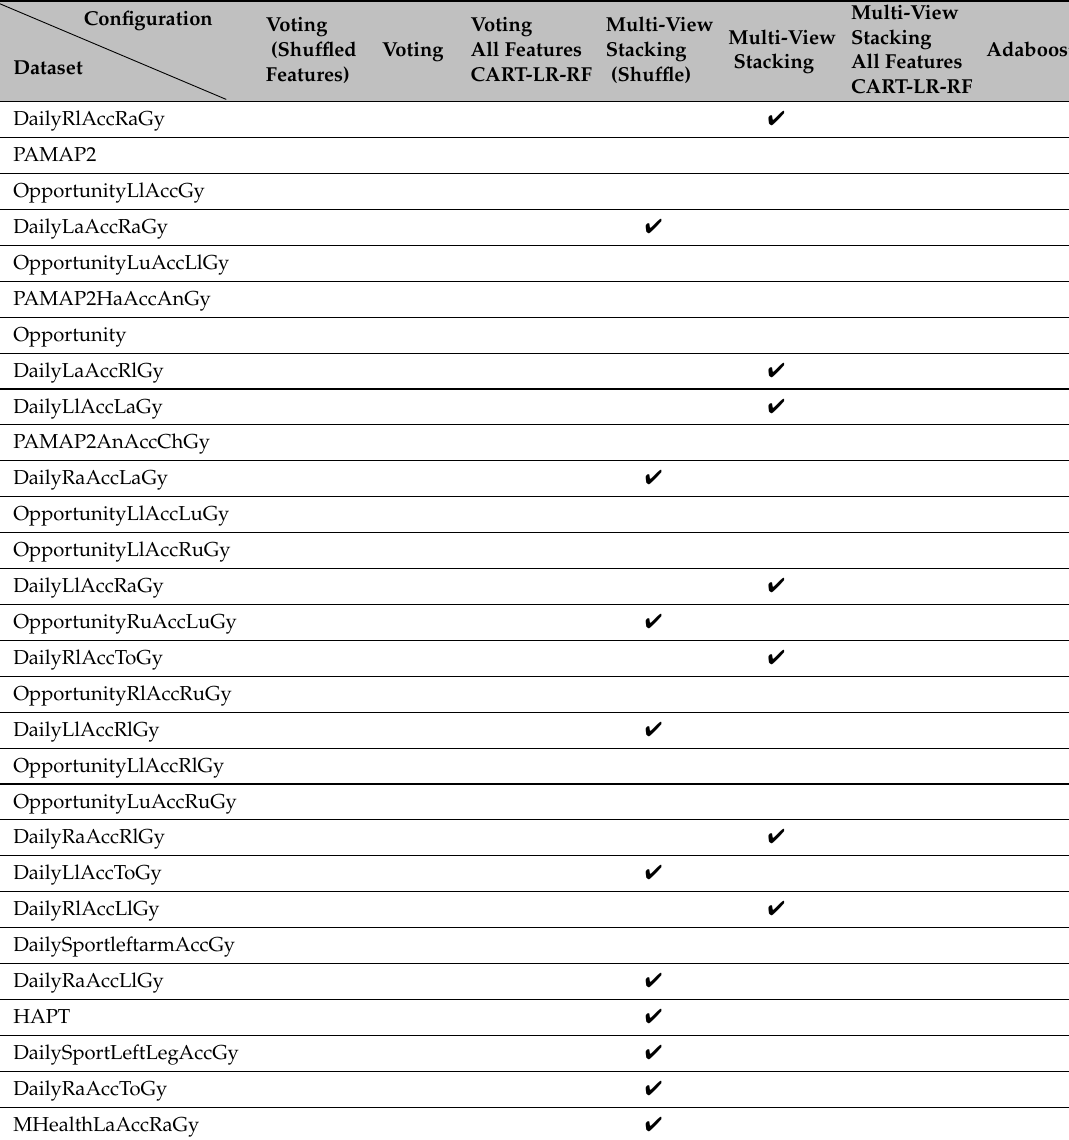
Table 2. Relationship between the configurations of the fusion methods and the datasets, with respect to the largest significant differences found when these configurations used Random Forest as a